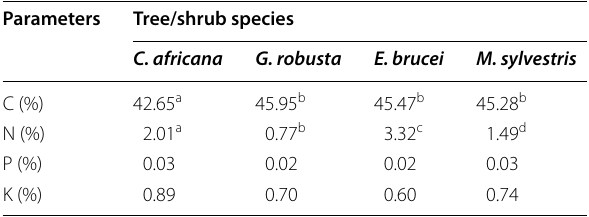
Means followed by different letters on the same rows indicate significant differences at P < 0.05. Source: Survey data.